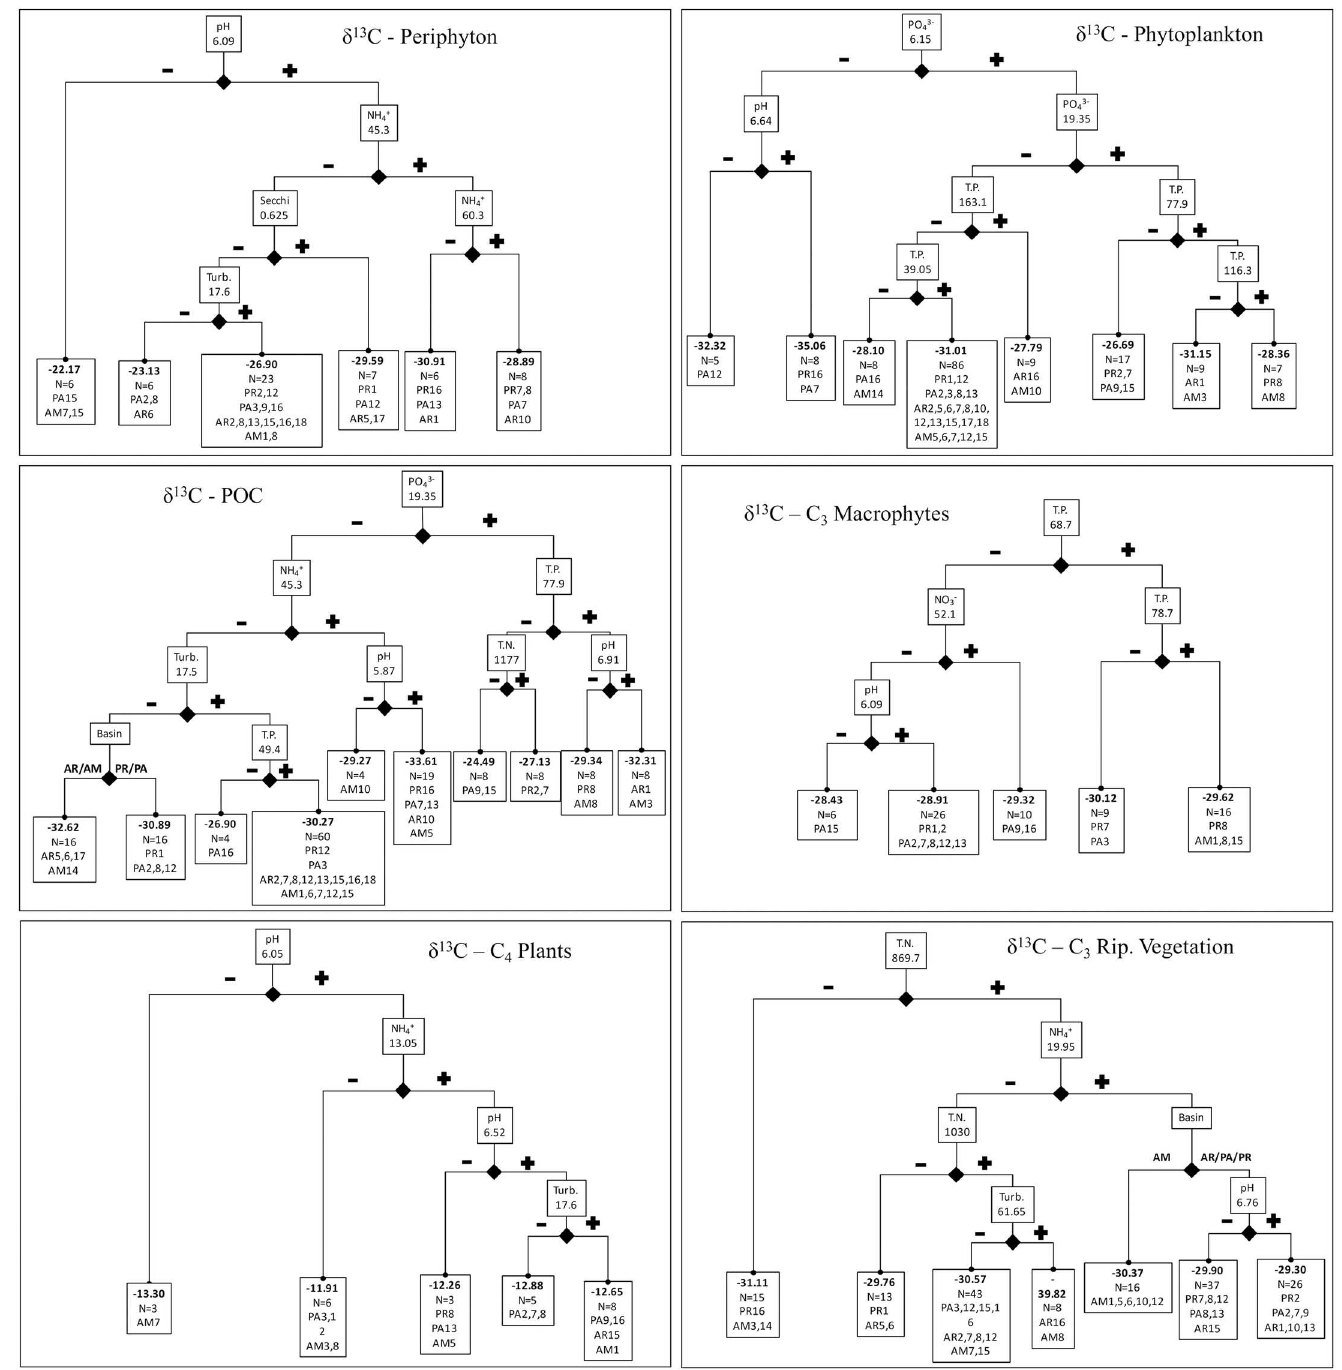
Fig 3. Regression trees predicting δ 13 C for each carbon source. Splits are identifiedby boxes on branches with the corresponding parameter and value, and terminal nodesare identifiedby boxes including the mean value for the responsevariable(i.e. δ 13 C) as well as the numberof samples and samplinglocationsincludedin the node. Plus and minus signs or basin abbreviations designatethe level of parameter to the left or right of a split (e.g. pH less than or greater than 6.09 for the first split for periphyton).